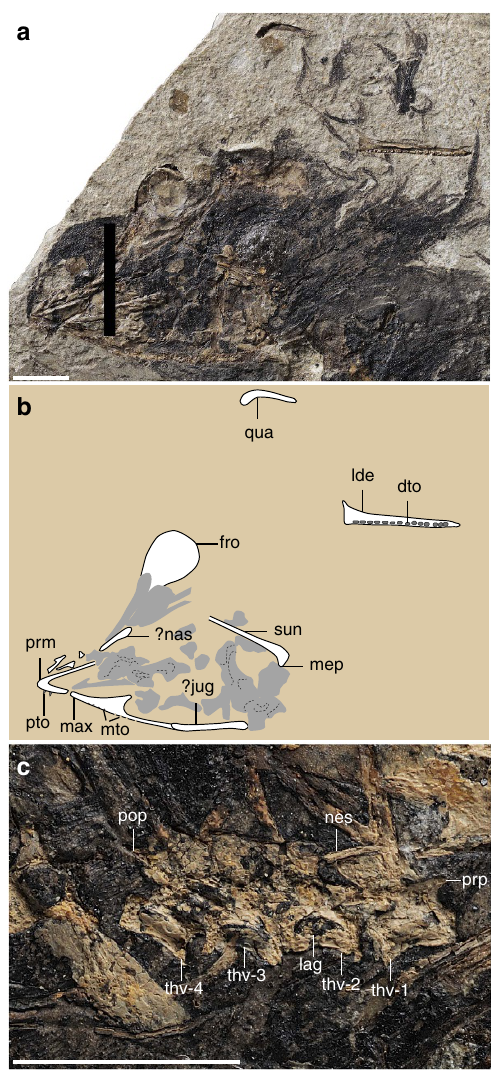
Figure 2 | Skull and thoracic vertebrae of C. multidonta (IVPP V21711). ( a ) Photograph, ( b ) and line drawing of the skull, ( c ) thoracic vertebrae; dto, dentary tooth; fro, frontal; jug, jugal; lag, lateral groove of centrum; lde, left dentary; max, maxilla; mep, medial process of surangular; mto, maxillary tooth; nas, nasal; nes, neural spine; pop, postzygapophysis; prm, premaxilla; prp, prezygapophysis; pto, premaxillary tooth; qua, quadrate; sun, surangular; thv1–4, preserved thoracic vertebra 1–4. Scale bars,